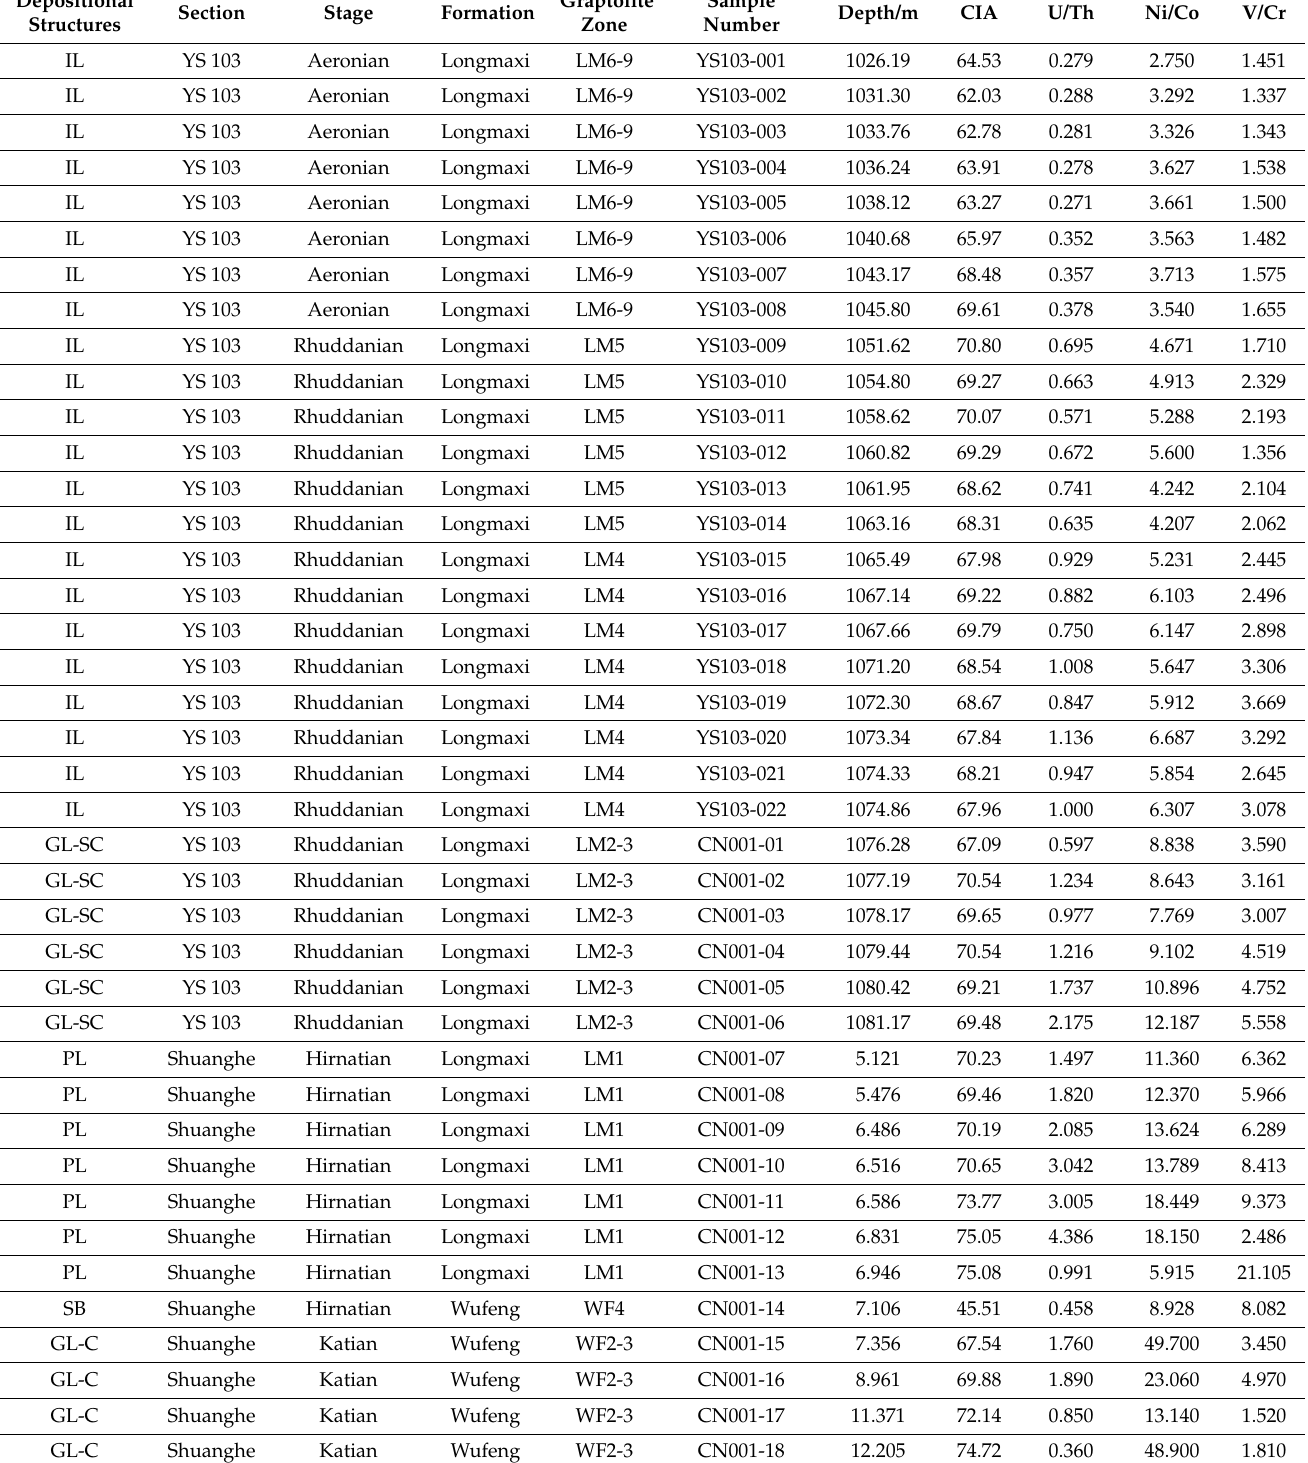
Table A2. CIA, U/Th, Ni/Co, and V/Cr values of samples from the Wufeng–Longmaxi shale in the Sichuan Basin of southwestern China. Abbreviations are shown in Table 1 (See